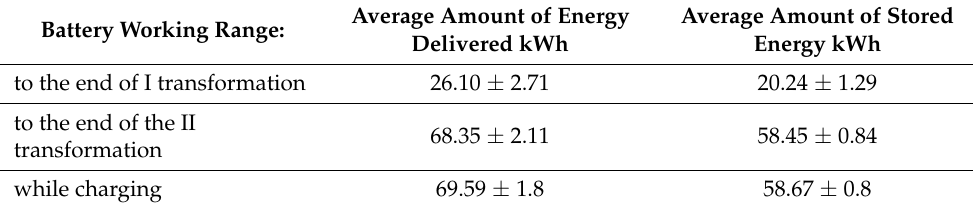
Table 2. Characteristics of the battery charging process in real conditions. Average Amount of Energy Average Amount of Stored Battery Working Range: Delivered kWh Energy kWh to the end of I transformation 26.10 ± 2.71 20.24 ± 1.29 to the end of the II